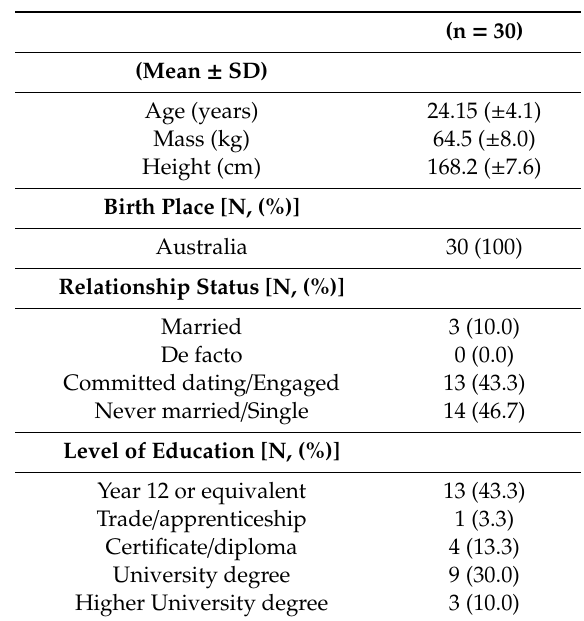
Table 1. Demographic characteristic of VFLW players (n = 30).